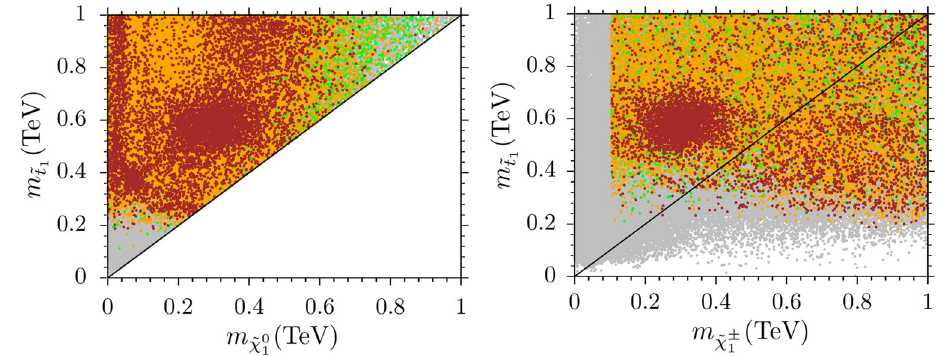
degeneracy between the plotted